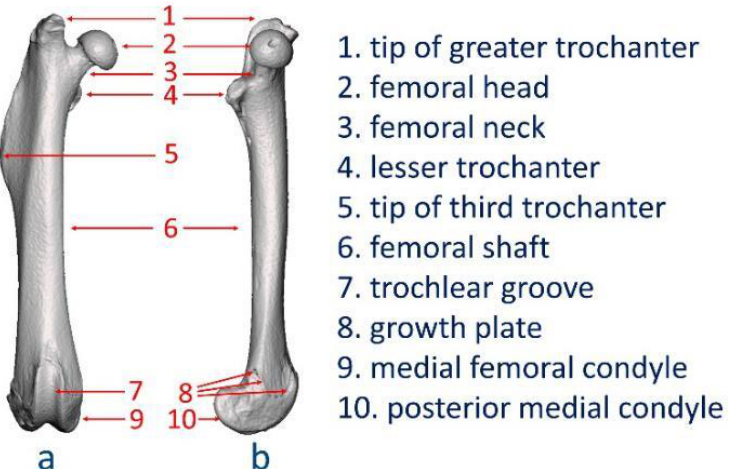
Figure 3. Anatomical surface landmarks: ( a ) Ventral-dorsal view; ( b ) medial view.